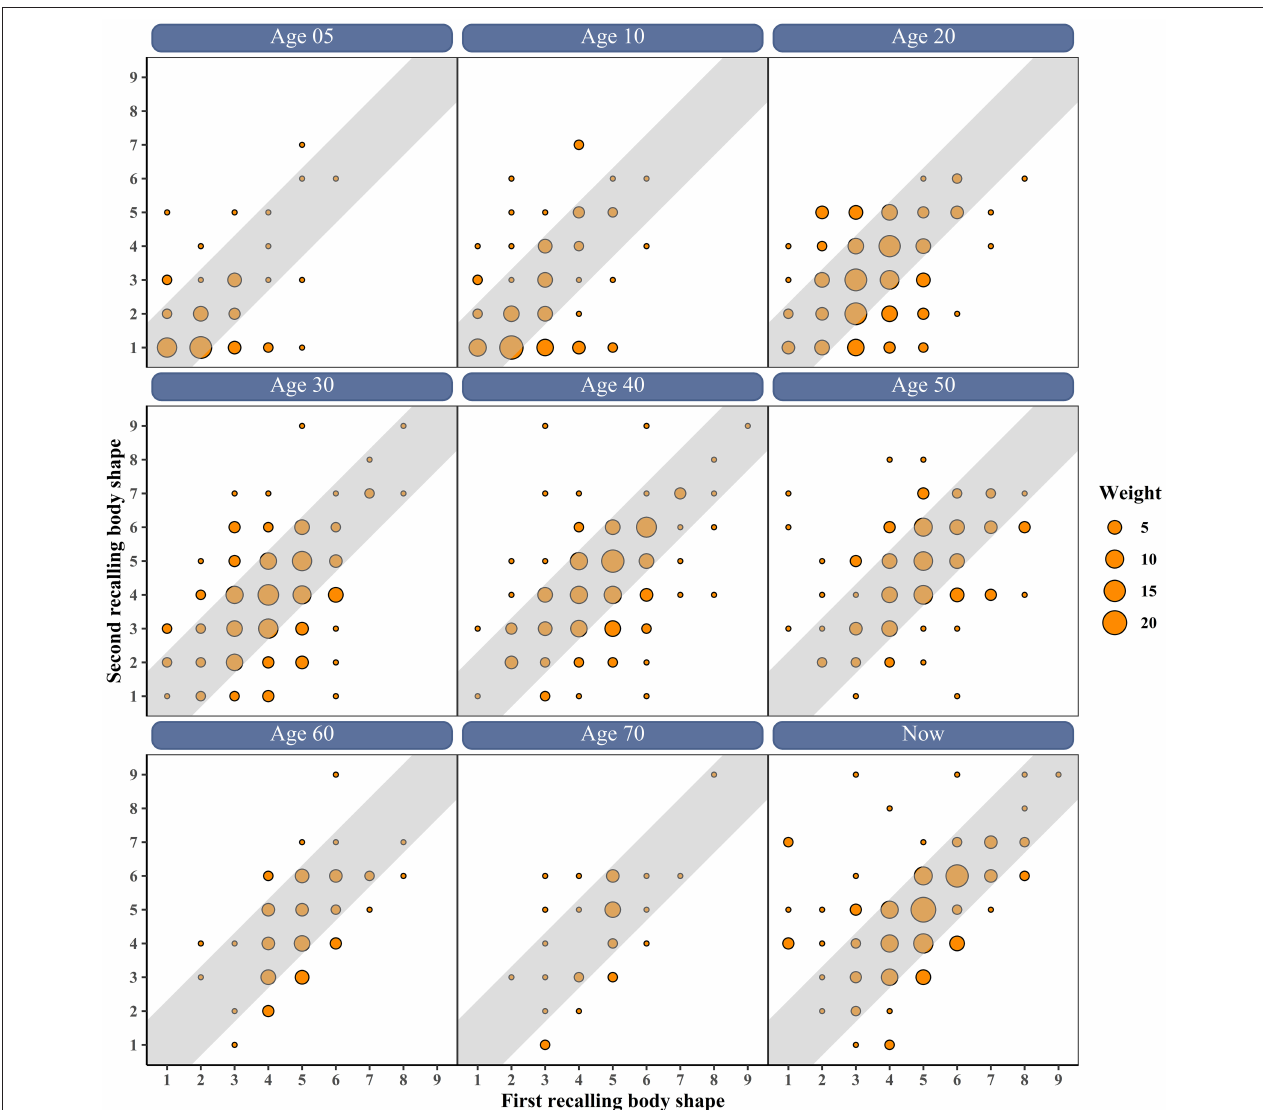
FIGURE 1 | The scatter plot of first vs. second recalled body shape at different